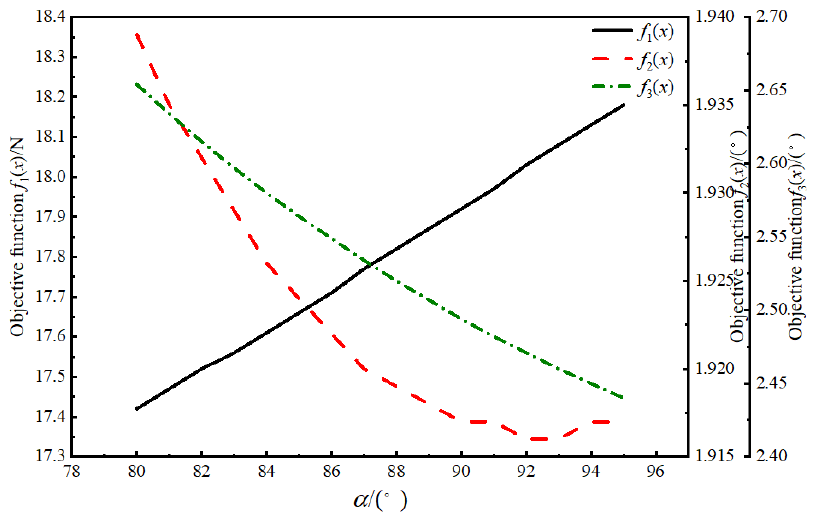
Figure 8. Variation curve of the objective function with the central angle α corresponding to the long side of the spherical hinge.